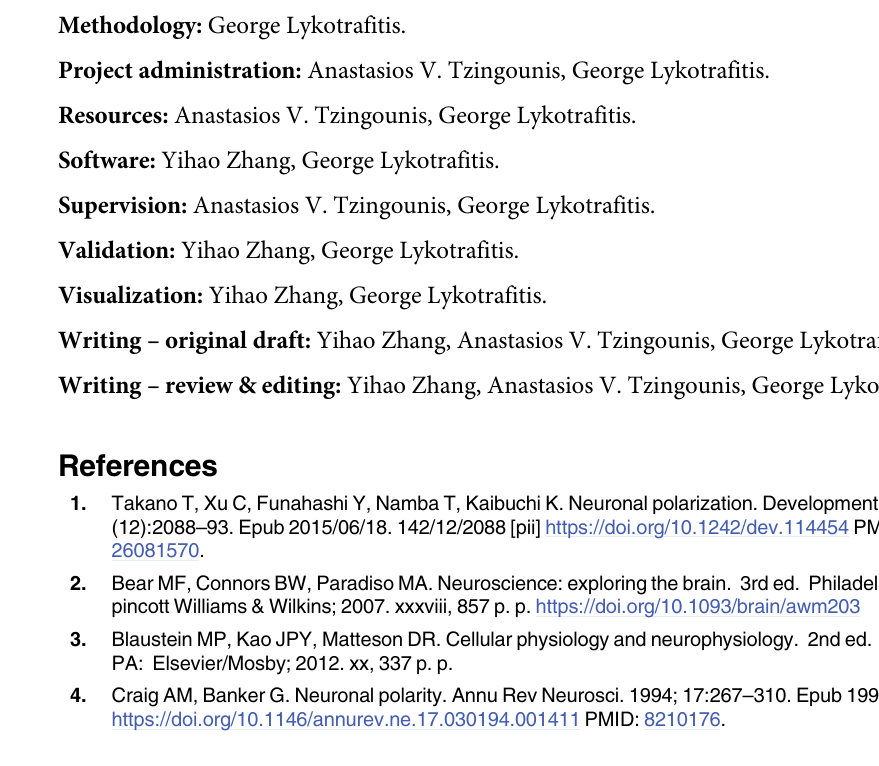
S2 Table. Longitudinal diffusion coefficients of membrane proteins and lipids. S3 Table. Transverse diffusion coefficients of membrane proteins and lipids. S4 Table. Diffusion coefficients of lipids and IMPs of the outer layer for different accumu- lation densities of immobile TMPs. S5 Table. Longitudinal and transverse diffusion coefficients of IMPs of the inner layer for different accumulation densities of immobile